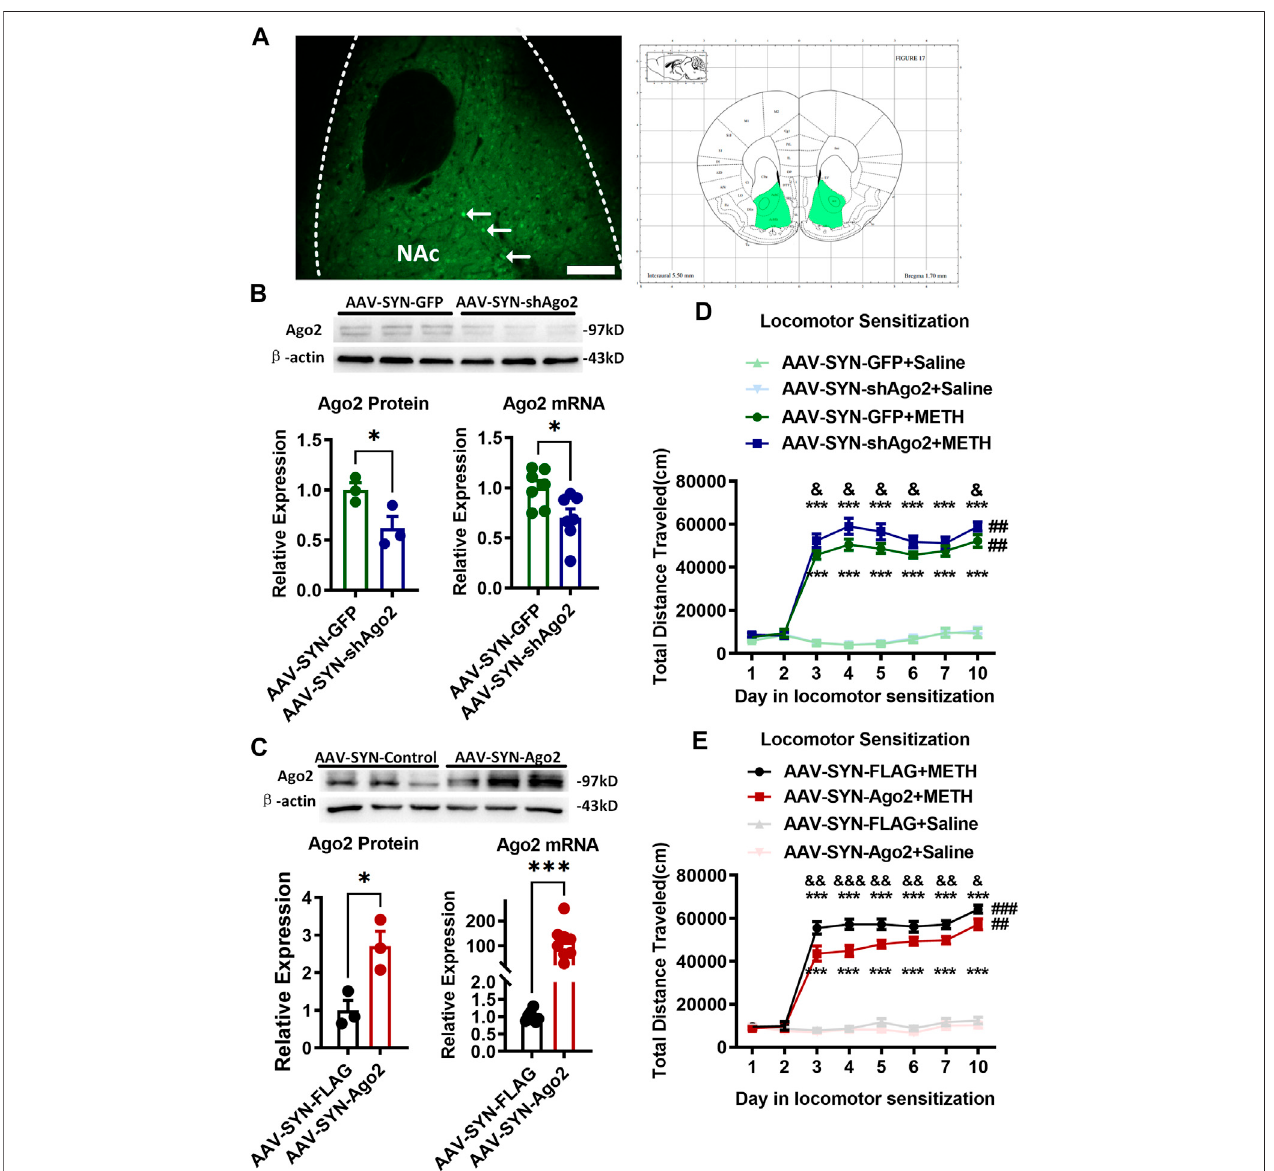
FIGURE 2 | Regulation of Ago2 in NAc neurons affected METH sensitization. (A) Fluorescence image showing the location of AAV expression and bilateral NAc (Franklin and Paxinos, 2001) of mouse neurons (arrows). Scale bar, 100 μ m. (B) Injection of AAV-SYN-shAgo2 into the NAc of mice effectively reduced Ago2 protein and mRNA levels. (C) Injection of AAV-SYN-Ago2 into the NAc of mice increased Ago2 protein and mRNA levels. Student ’ s t -test showed *** p < 0.001 compared to the virus control group. The data are presented as the mean ± SEM, n (cid:2) 3 – 7. (D) Ago2 downregulation in NAc neurons enhanced METH sensitization. (E) Ago2 overexpression in NAc neurons attenuated METH sensitization. Mixed-measures ANOVA showed the following: * p < 0.05, *** p < 0.001, vs. the corresponding saline groups; & p < 0.05, && p < 0.01, vs. AAV-SYN-GFP+METH or AAV-SYN-FLAG+METH; ## p < 0.01, compared to the locomotor activities recorded on day 3 within the same group. The data were presented as the mean ± SEM, n (cid:2) 8 – 12. NAc, nucleus accumbens; METH sensitization, METH-induced locomotor sensitization.